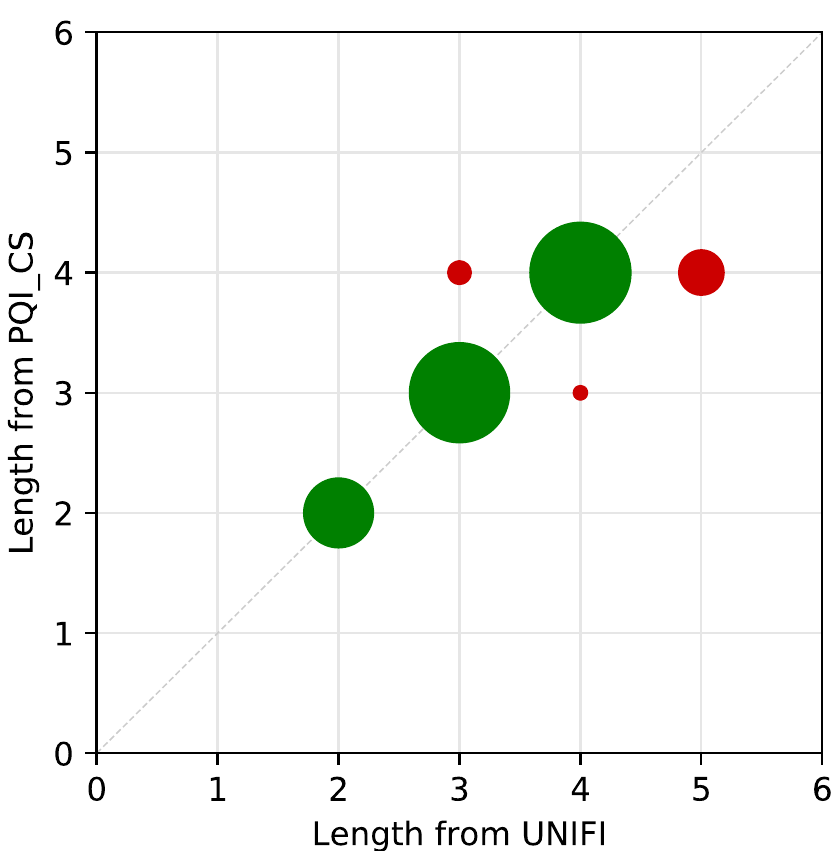
Figure 10. Length assignment discrepancies by the untargeted method in relation to peptide map- ping. Green circles represent peptide identification overlap between the two identification methods, whereas red circles represent mismatches between peptide identifications. Circle areas are scaled to represent the ratios between matched and mismatched peptides.